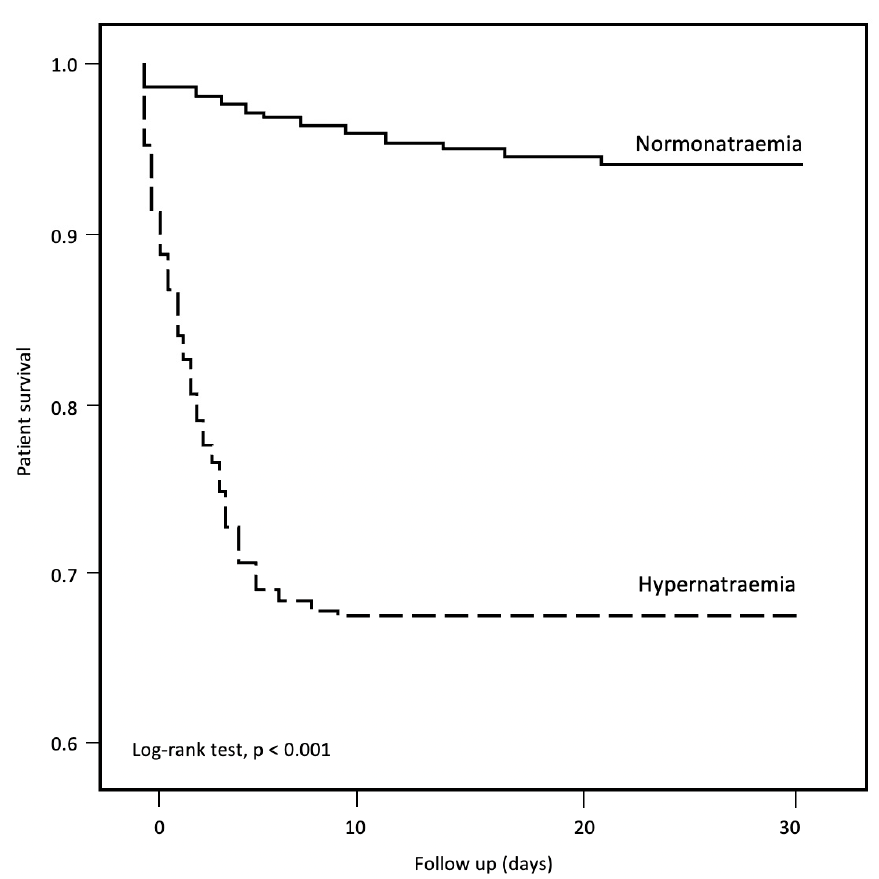
Figure 2. Thirty-day mortality in COVID-19 patients with hypernatraemia and normonatraemia. Table 8. Clinical characteristics of COVID-19 patients who died within 30 days.